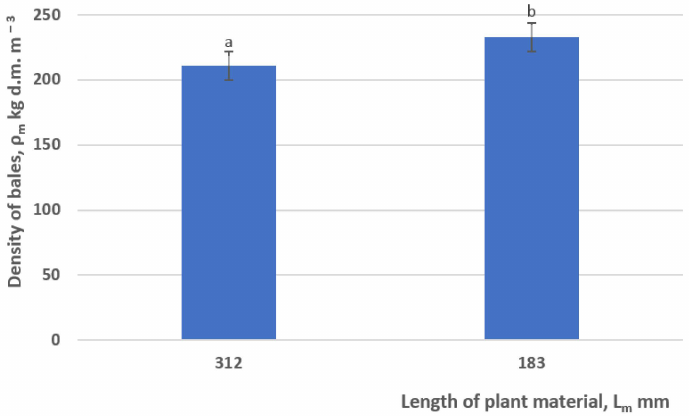
Figure 10. Bar chart of balage density in bales for two different plant material lengths (Lm) at 56% moisture content and a pressing pressure of 18 MPa. Different lowercase letters indicate a statistically significant difference at p ≤ 0.05; d.m., dry matter.